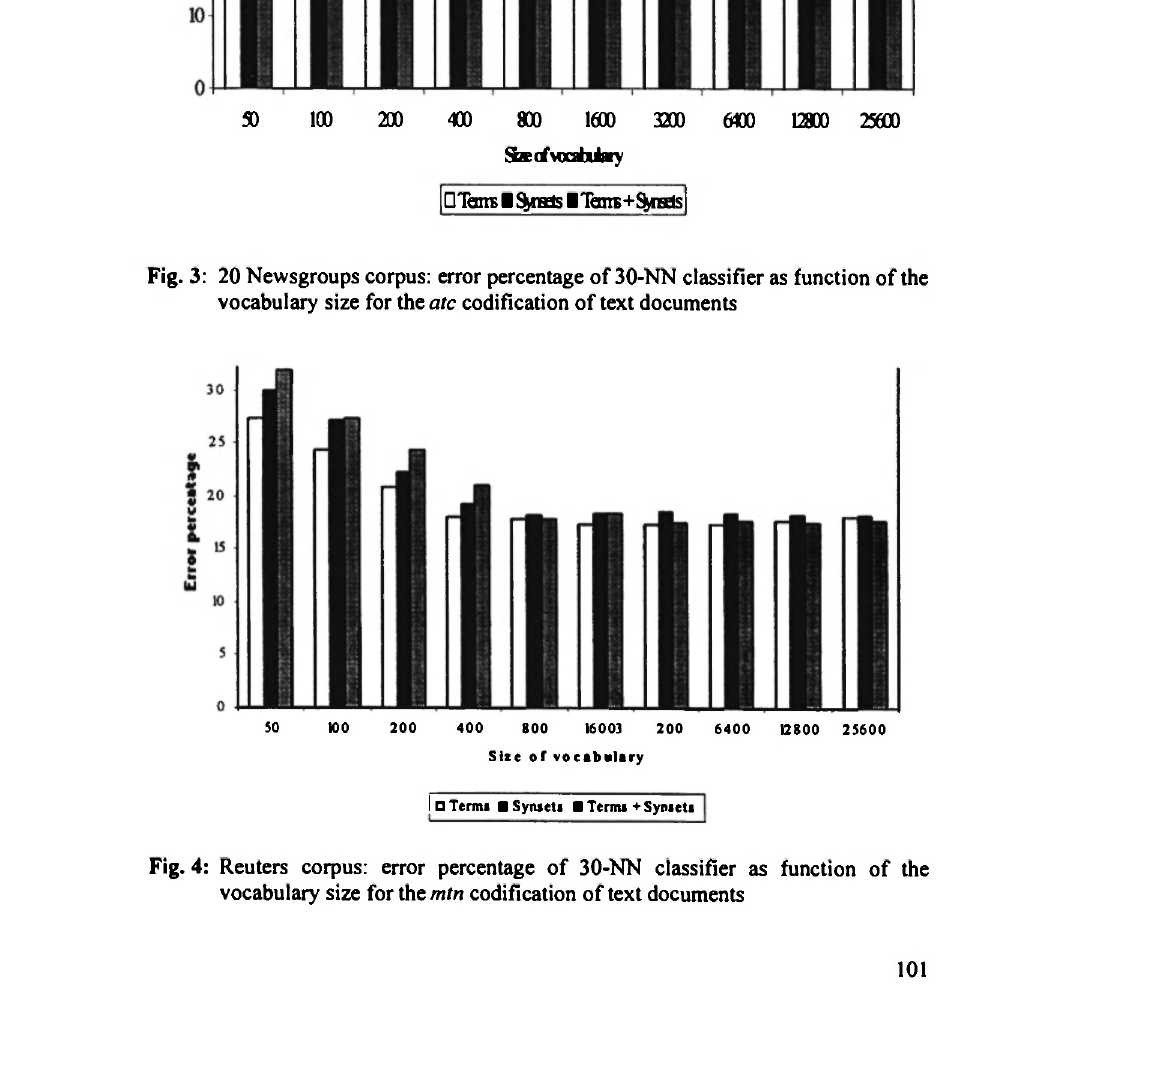
Fig. 3: 20 Newsgroups corpus: error percentage of 30-NN classifier as function of the vocabulary size for the ate codification of text documents